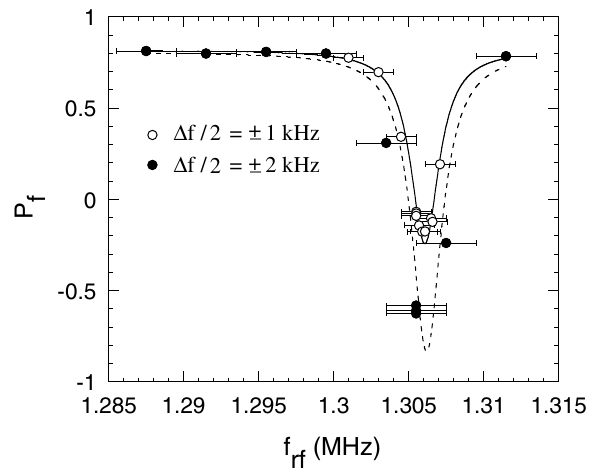
FIG. 2. The measured proton polarization at 1 : 941 GeV =c is plotted against the central frequency of each ramp; each ramp’s (cid:15) f range is shown by a horizontal bar. The rf dipole’s R B was 0.11 T mm; its (cid:15) t was 10 s. The curve is a fit using a first- order Lorentzian.